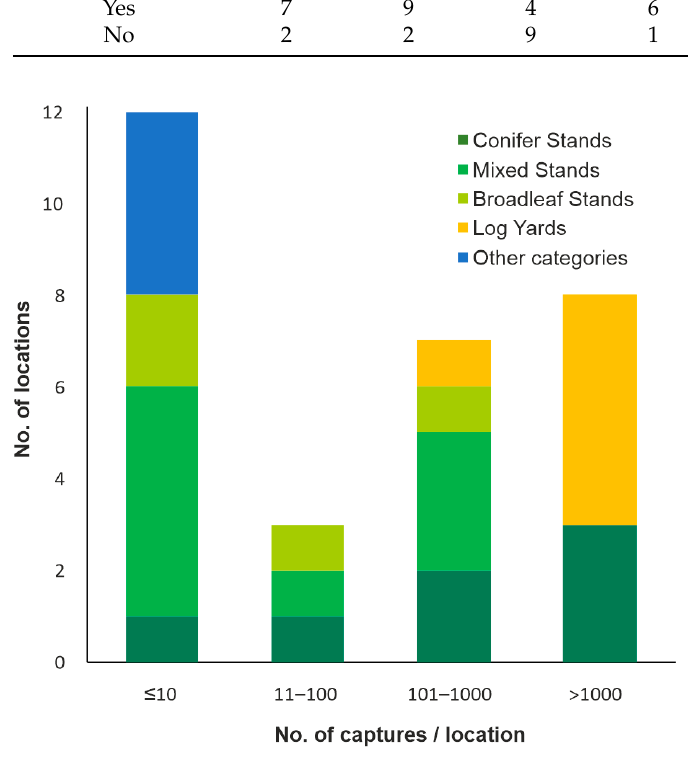
Figure 2. Number of locations and habitats with different NBB capture sizes.